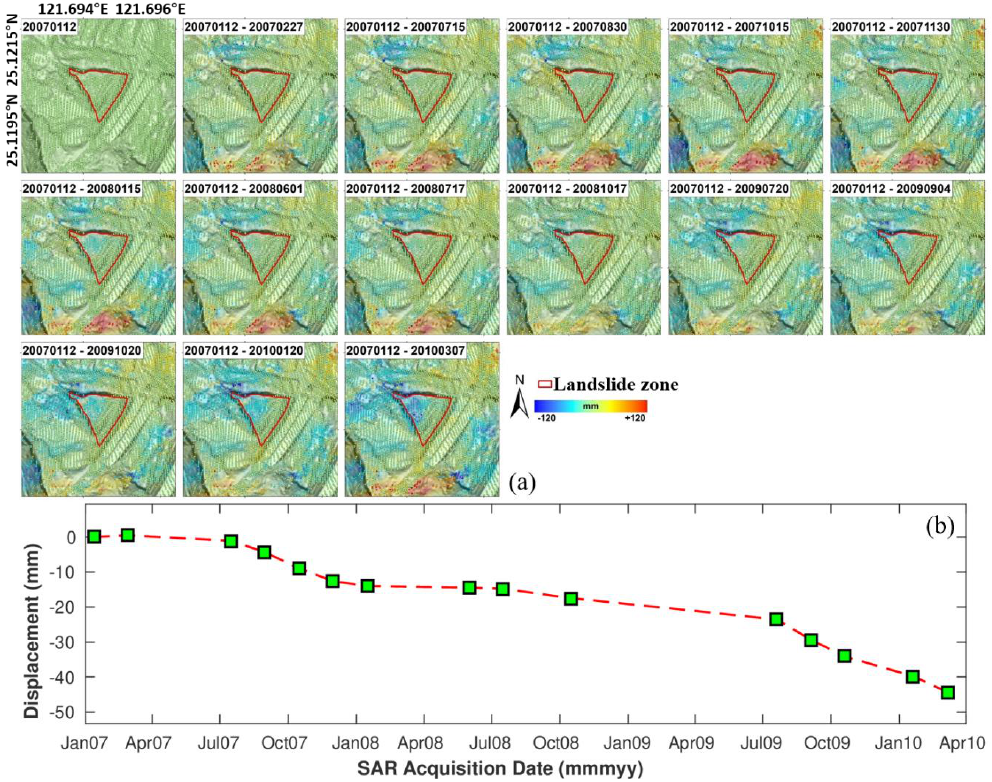
Figure 8. ( a ) Time-series displacement map of the artificial side slope along Freeway No. 3. ( b ) Average amount of cumulative displacement within the enclosed landslide region.